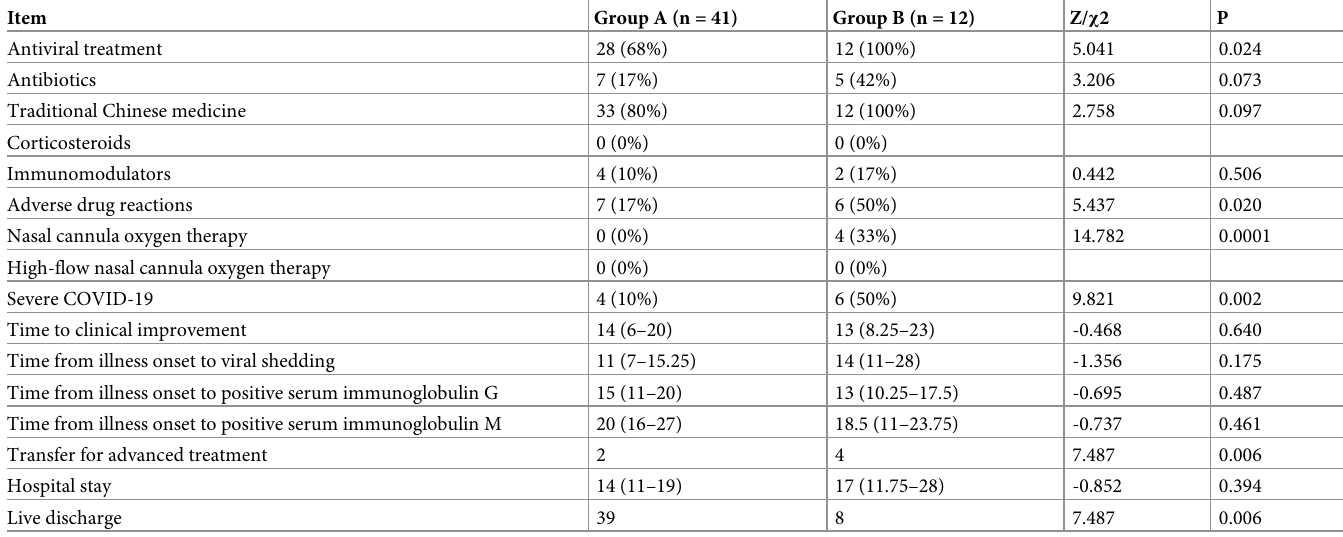
Table 5. Treatment and turnover of the two